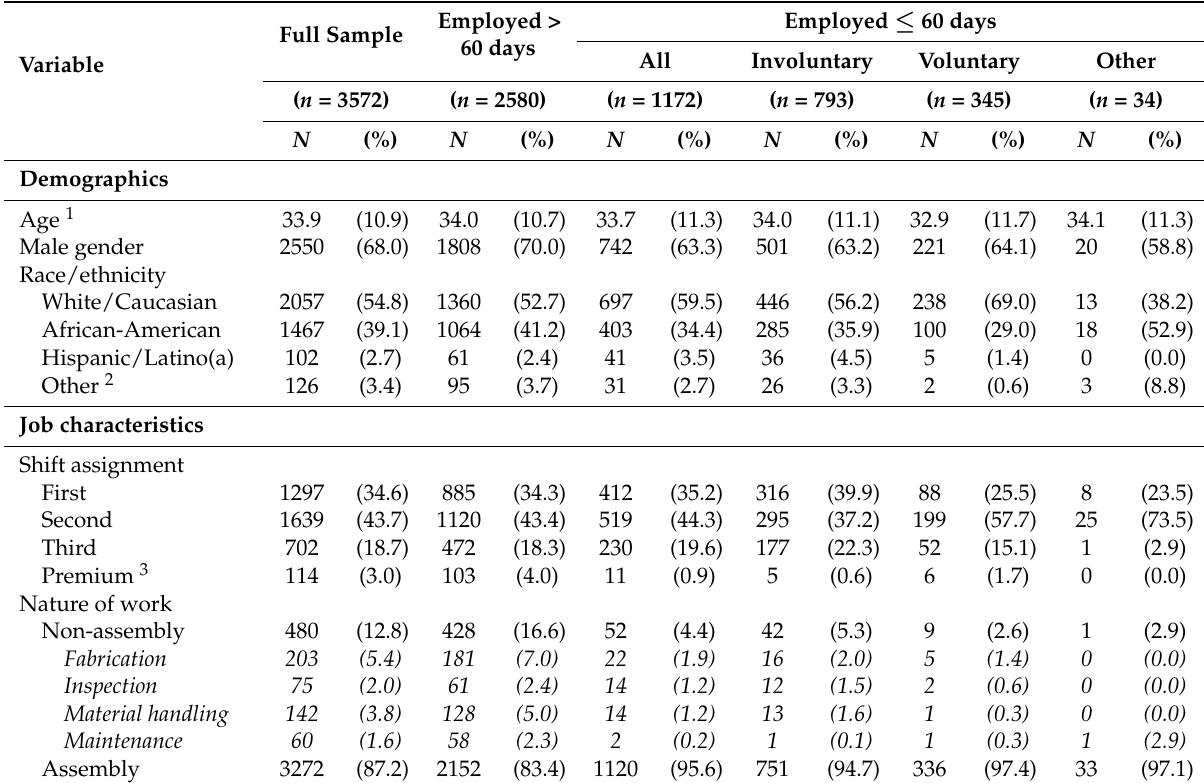
Table 1. Demographic and job characteristic